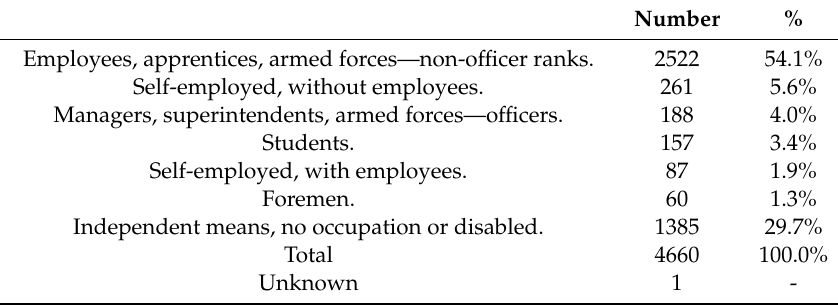
Table 1. Suicide by employment status (16–64-year-olds). Number % Employees, apprentices, armed forces—non-o ffi cer ranks. 2522 54.1% Self-employed, without employees. 261 5.6% Managers, superintendents, armed forces—o ffi cers. 188 4.0% Students. 157 3.4% Self-employed, with employees. 87 1.9% Foremen. 60 1.3% Independent means, no occupation or disabled. 1385 29.7% Total 4660 100.0% Unknown 1